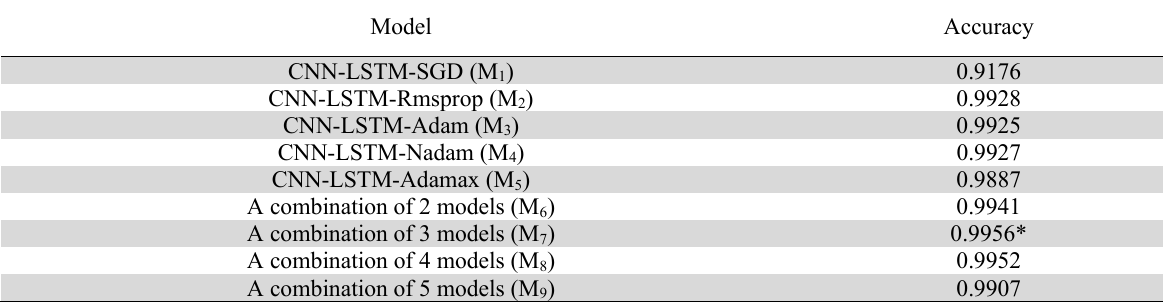
The performance of each model on ISOT fake news dataset